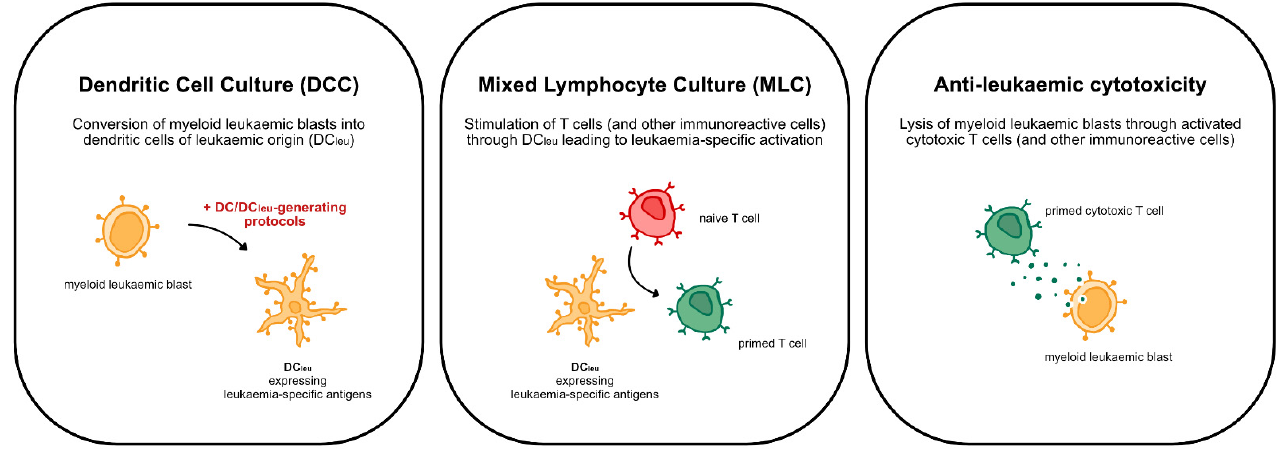
Figure 1. Overview of the concept of DC/DC leu -based immunotherapy depicting the steps of generating DC leu through DC/DC leu -generating protocols in the dendritic cell culture (DCC) and stimulating T cell enriched immunoreactive cells with generated DC leu in the mixed lymphocyte culture (MLC), overall leading to anti-leukaemic cytotoxicity of T cell enriched immunoreactive cells.